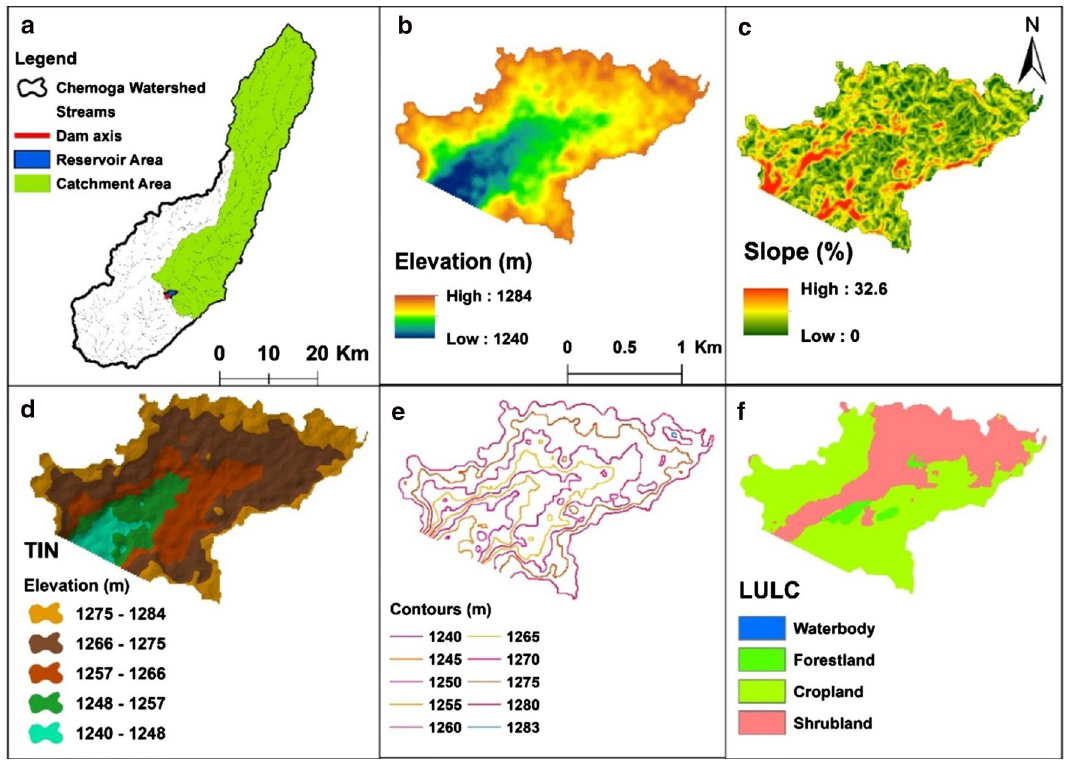
Fig. 16 Evaluation parameters for proposed Dam site 3: a Catchment area, b DEM, c slope, d triangulated irregular network (TIN), e contours, f